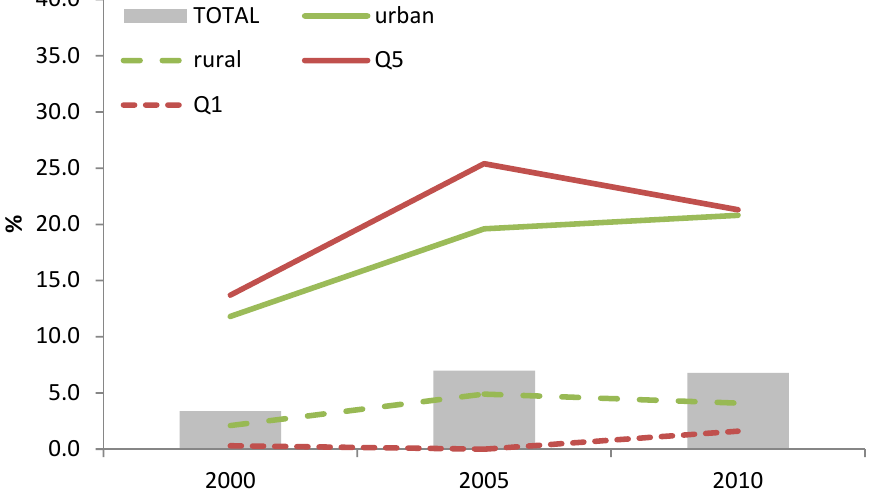
Figure 2. Trends in breast-milk substitutes (BMS) use among children 0–5.9 months of age according to maternal education, household wealth (richest = Q5; poorest = Q1) or living